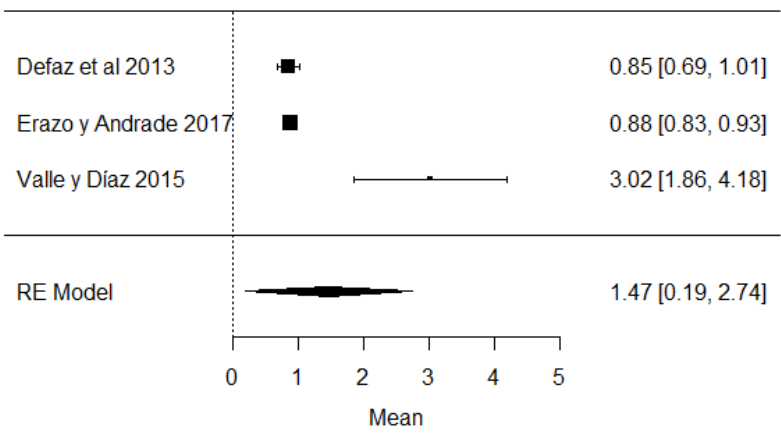
Figure 16. Forest plot of added water [39,61,63].